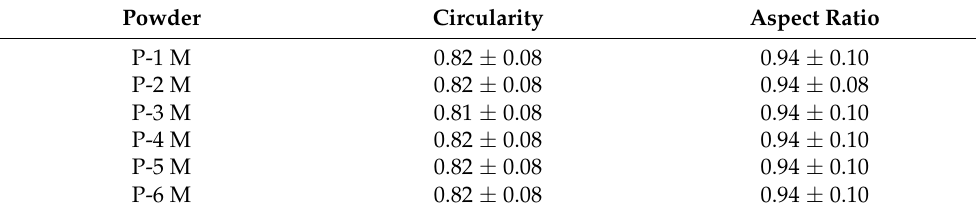
Table 2. The mean and standard deviation values for the aspect ratio and the circularity for milled (30 min) magnetocaloric powders P-1 M–P-6